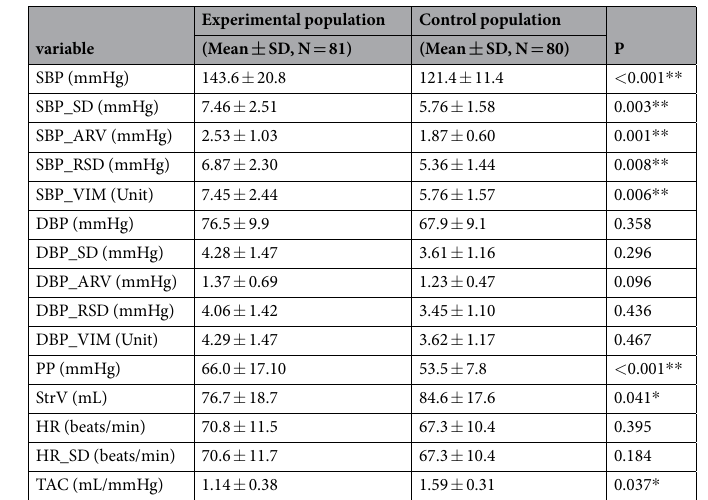
Table 2. BP parameters, HR, pulse pressure, stroke volume and TAC of 81 hypertensive subjects and 80 normal subjects. SBP, systolic blood pressure; DBP, diastolic blood pressure; SD, standard deviation; ARV, average real variability; RSD, residual standard deviation; VIM, variation independent of mean; HR, heart rate; PP, pulse pressure; StrV, stroke volume; TAC, total arterial compliance. * p < 0.05; ** P < 0.01.